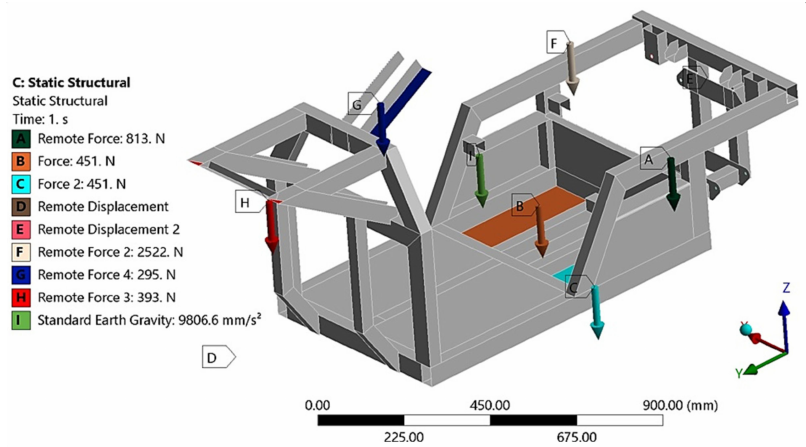
Figure 12. Boundary conditions of the first limit